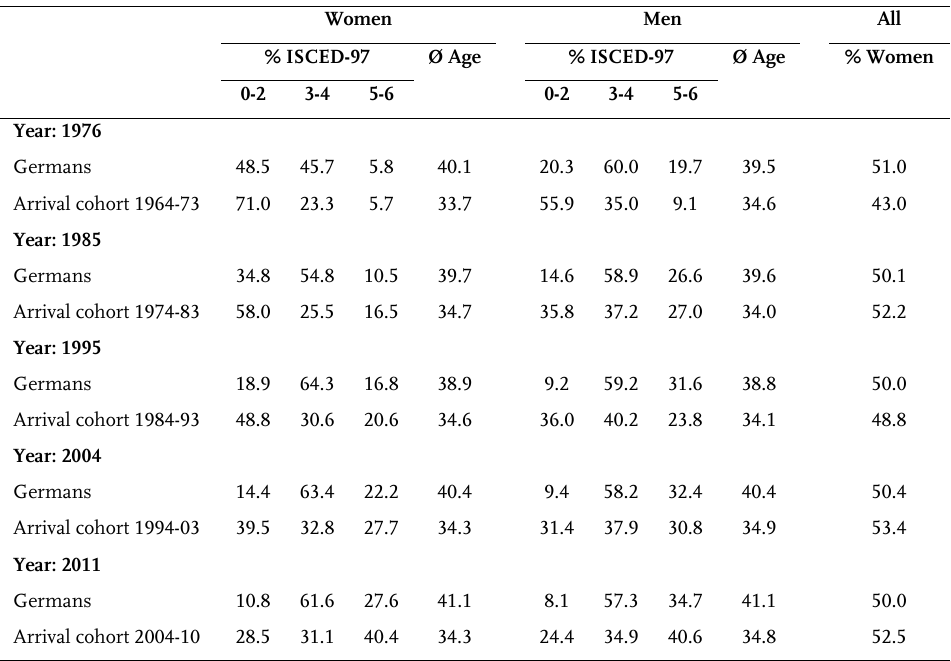
Table 1 : Education and age composition by selected year, arrival cohort and gender Table 1. Education and age composition by selected years, arrival cohort and gender Women Men All % ISCED-97 Ø Age % ISCED-97 Ø